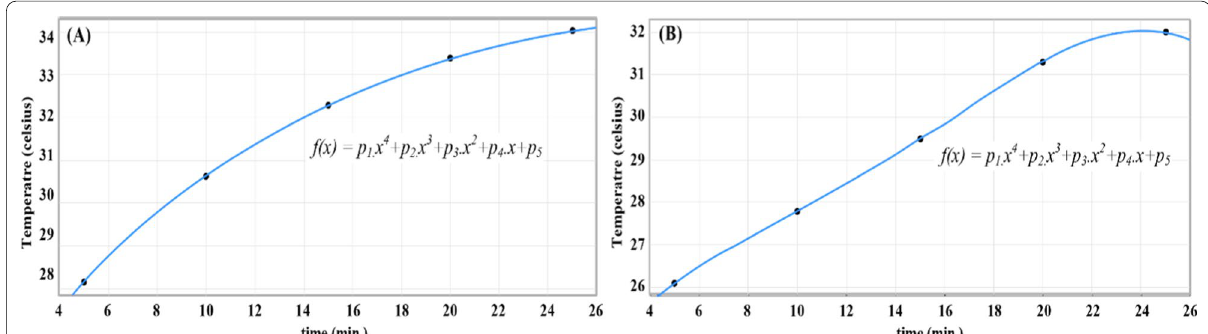
Fig. 7 Temperature vs. time, by using brackish groundwater in case of closed cycle: A at flow rate of 52.16 l/min and B at flow rate of 12.32 l/min